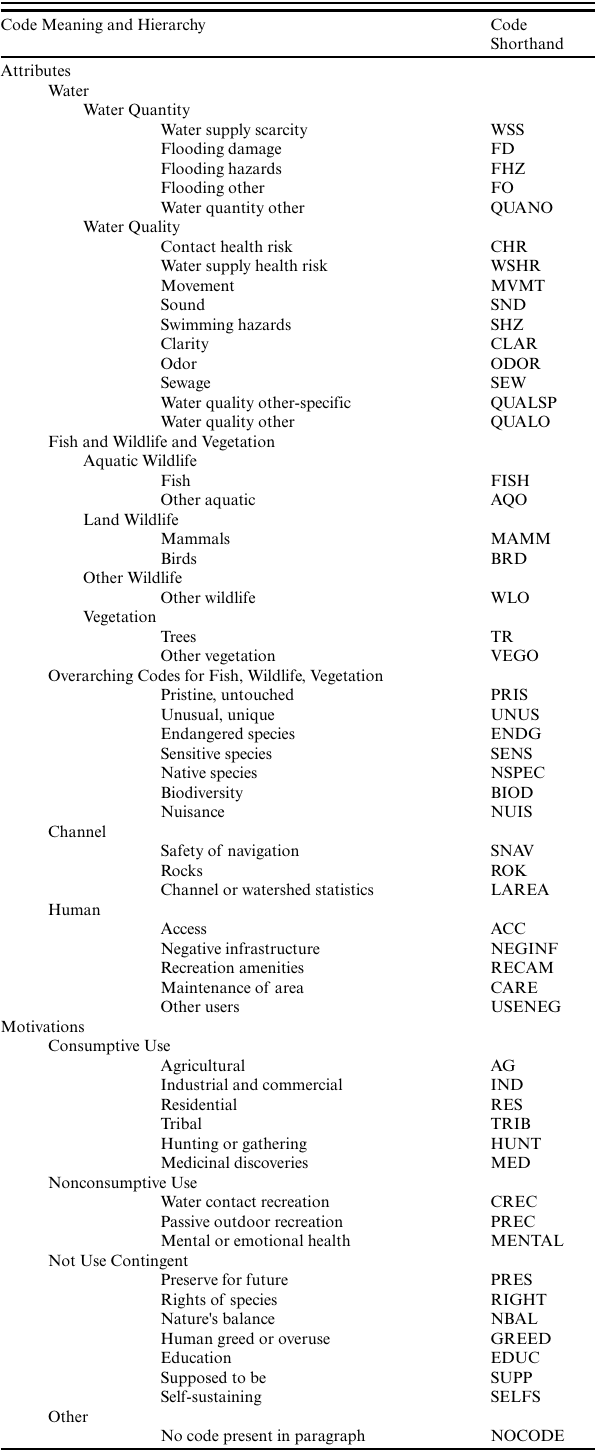
Table 1 . Attribute and motivation categories, codes, and